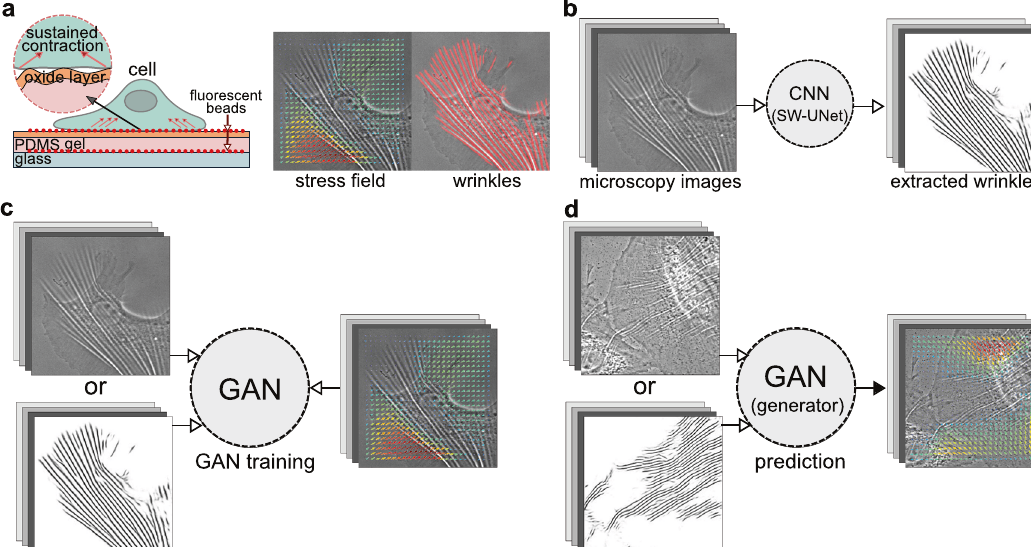
Fig. 1 Overview of the methods and procedures that are utilized in the wrinkle force microscopy (WFM). a Schematic of our experimental setup. A silicone membrane, which can evaluate the cellular force distribution (obtained by TFM) and the surface wrinkles simultaneously, is utilized in this work. b The surface wrinkles are extracted from the microscope images by using our machine learning system (SW-UNet). c The machine learning system (GAN) is trained to understand the relation between the input images (raw microscope image, or extracted wrinkle images) and corresponding output images (cellular force distribution). d After suf fi cient training, WFM can predict the force distributions only from the microscope